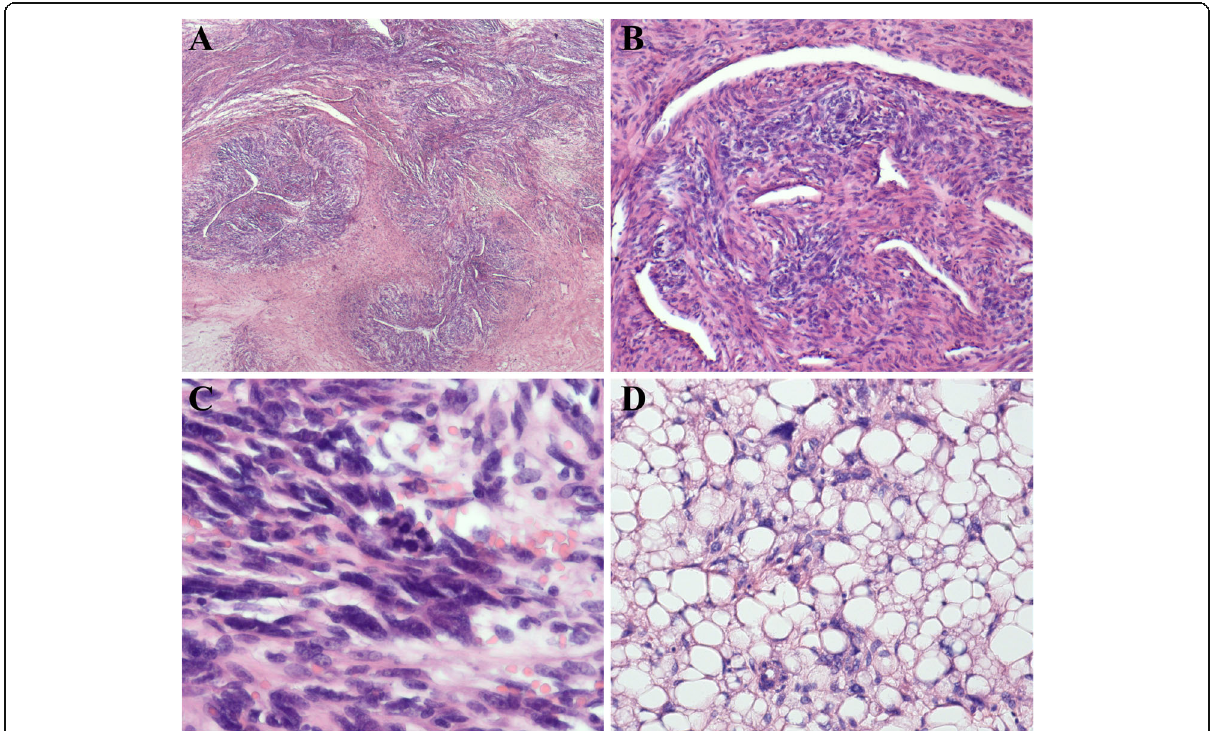
Fig. 2 Histologic features of vaginal dedifferentiated liposarcoma. a , The tumor was composed of loose fascicles of relatively bland myofibroblast- like cell in fibrous stroma, and resembles fibromatosis. b , The cytopathologic features of the tumor showed hypercellularity and infiltrative overgrowth of spindle cells with nuclear atypia. c , Mitosis could be seen in the high cellularity areas. The red arrow indicate the mitosis. d , Well- differentiated liposarcoma component could be find in the excision specimen, which could contribute to the diagnosis of dedifferentiated